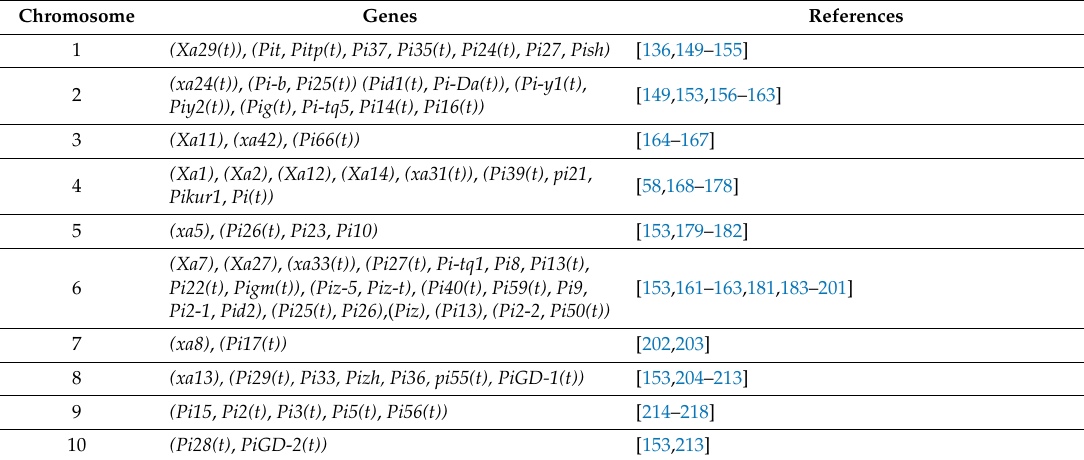
Table 1. Details of the resistance genes identified from